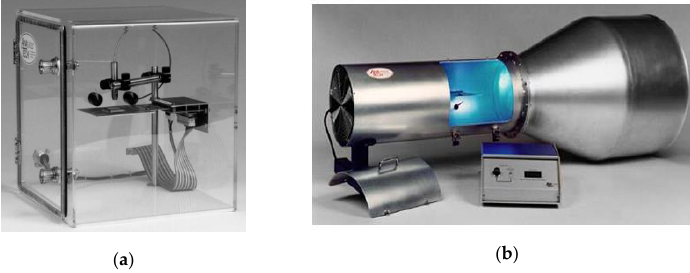
Figure 4. Standardized experimental setups for natural convection ( a ) and forced convection ( b ).